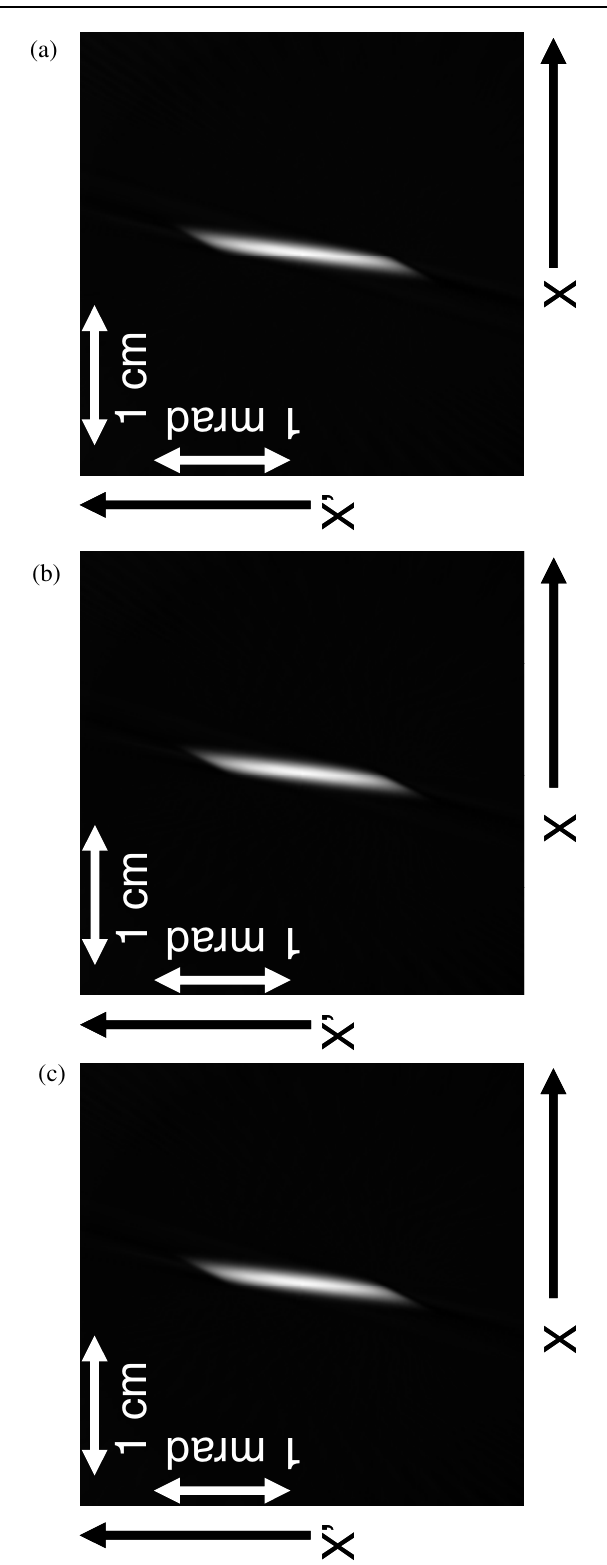
FIG. 5. X 0 X phase space distribution of the pencil beam with different simulated systematic errors. (a) 1% error, (b) 2% error, (c) 4%